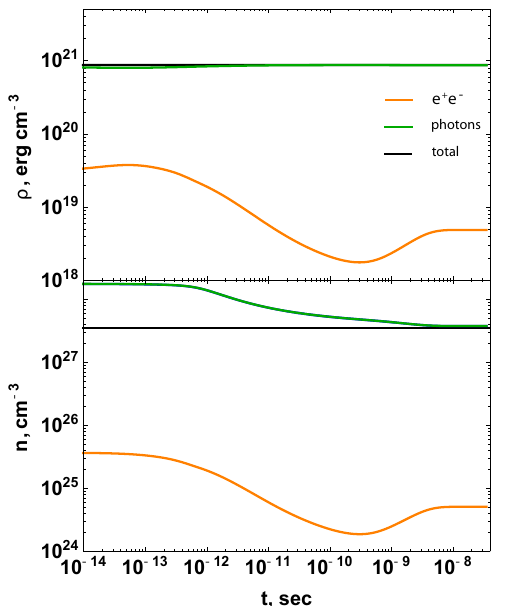
Figure 3. Time evolution of energy density (top) and particle number density (bottom) of photons (blue), electrons/positrons (orange), all together (green) in nonrelativistic case. Black line represents the final equilibrium quantity. Final equilibrium temperature is θ = k B T / m e c 2